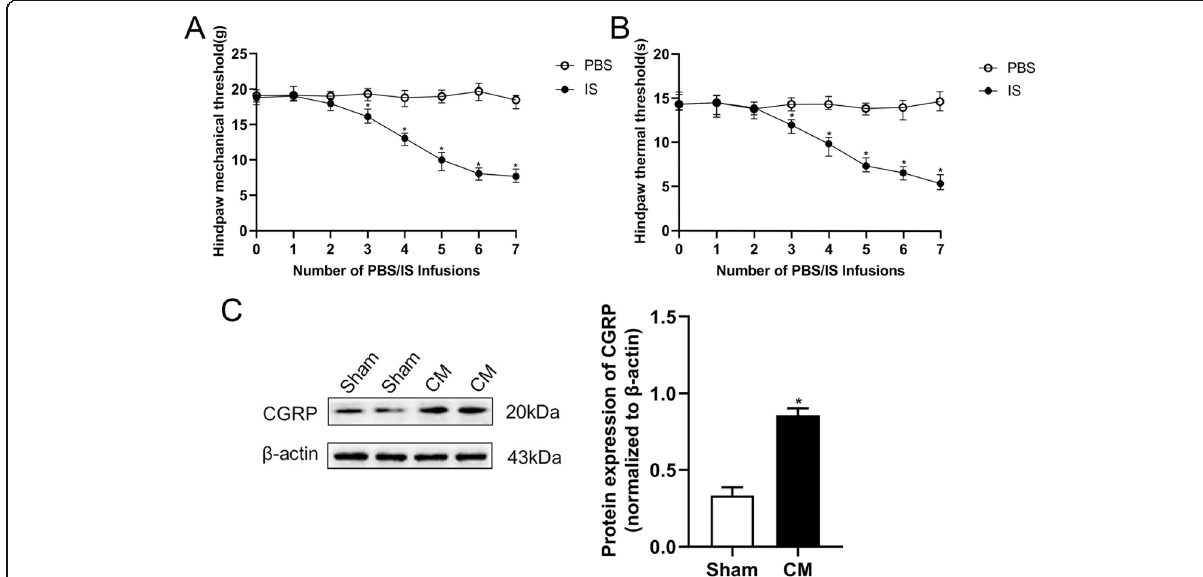
Fig. 1 Repeated IS infusions induced mechanical allodynia and thermal allodynia and upregulated the expression of CGRP in the rats. a The mechanical pain thresholds of the hind paw during the infusion of PBS/IS. b The thermal pain thresholds of the hind paw during the infusion of PBS/IS. c The protein expression of CGRP. ( n = 6 in each group; * p < 0.05 compared with the sham group)